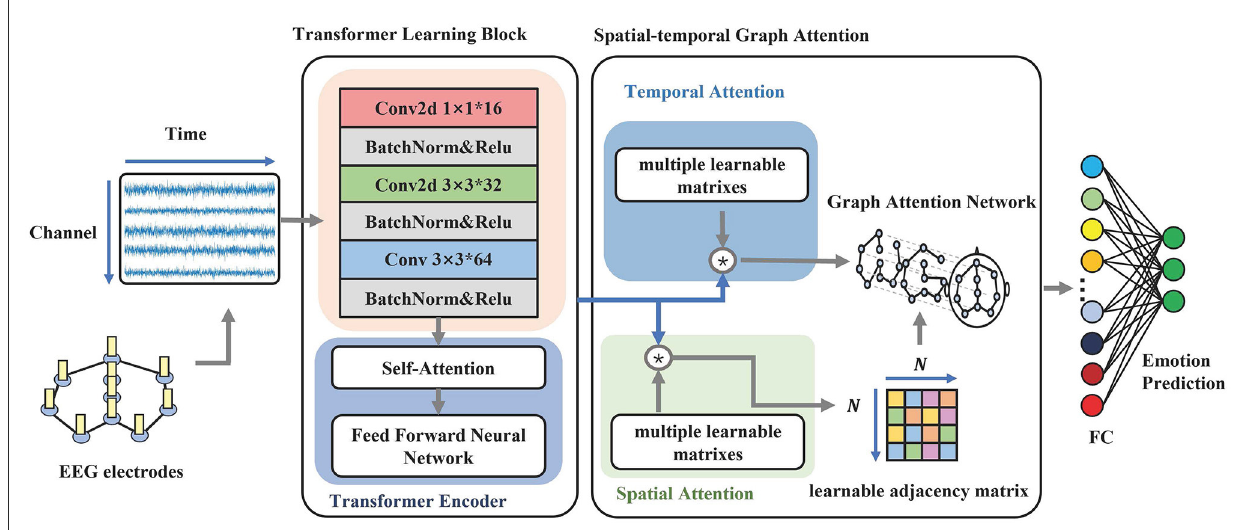
FIGURE1 The overall structure of STGATE. The model contains two main modules, Transformer Learning Block and Spatial-Temporal Graph Attention. The first module aims to learn time-frequency representations. The second module focuses on building dynamic graph representations by using an attention